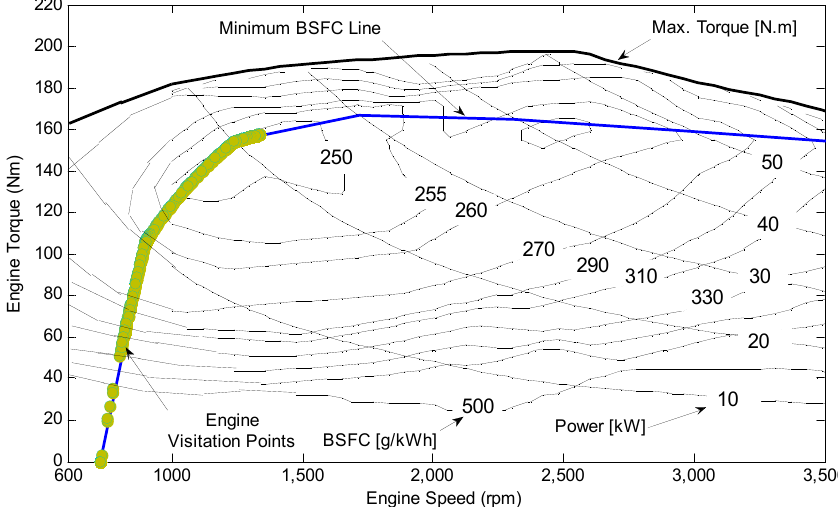
Figure 14. Engine Visitation Points under Japan 1015 Driving Cycle.